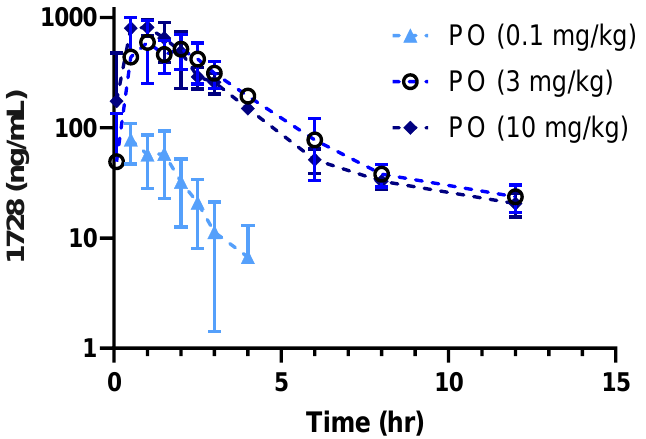
Figure 2. Dose dependent exposure after oral dosing in cats. Fasted cats ( n = 3) received increasing doses of EC1728. The maximum exposure was achieved at 3 mg/kg, and bioavailability decreased at the high dose without affecting terminal elimination (Table 3). Table 3. Summary of key PK parameters after oral dosing in cats.